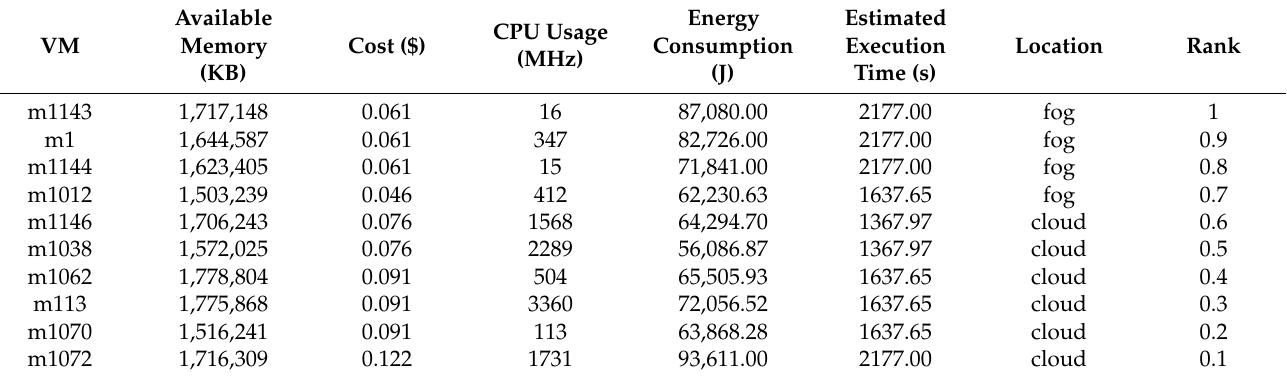
Table 12. Optimization results Task 224334 for a memory-driven and cost-driven use case with